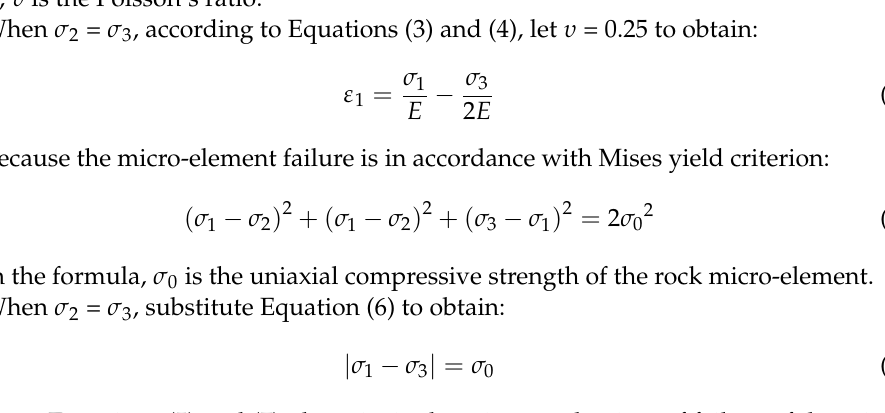
model; υ is the Poisson’s